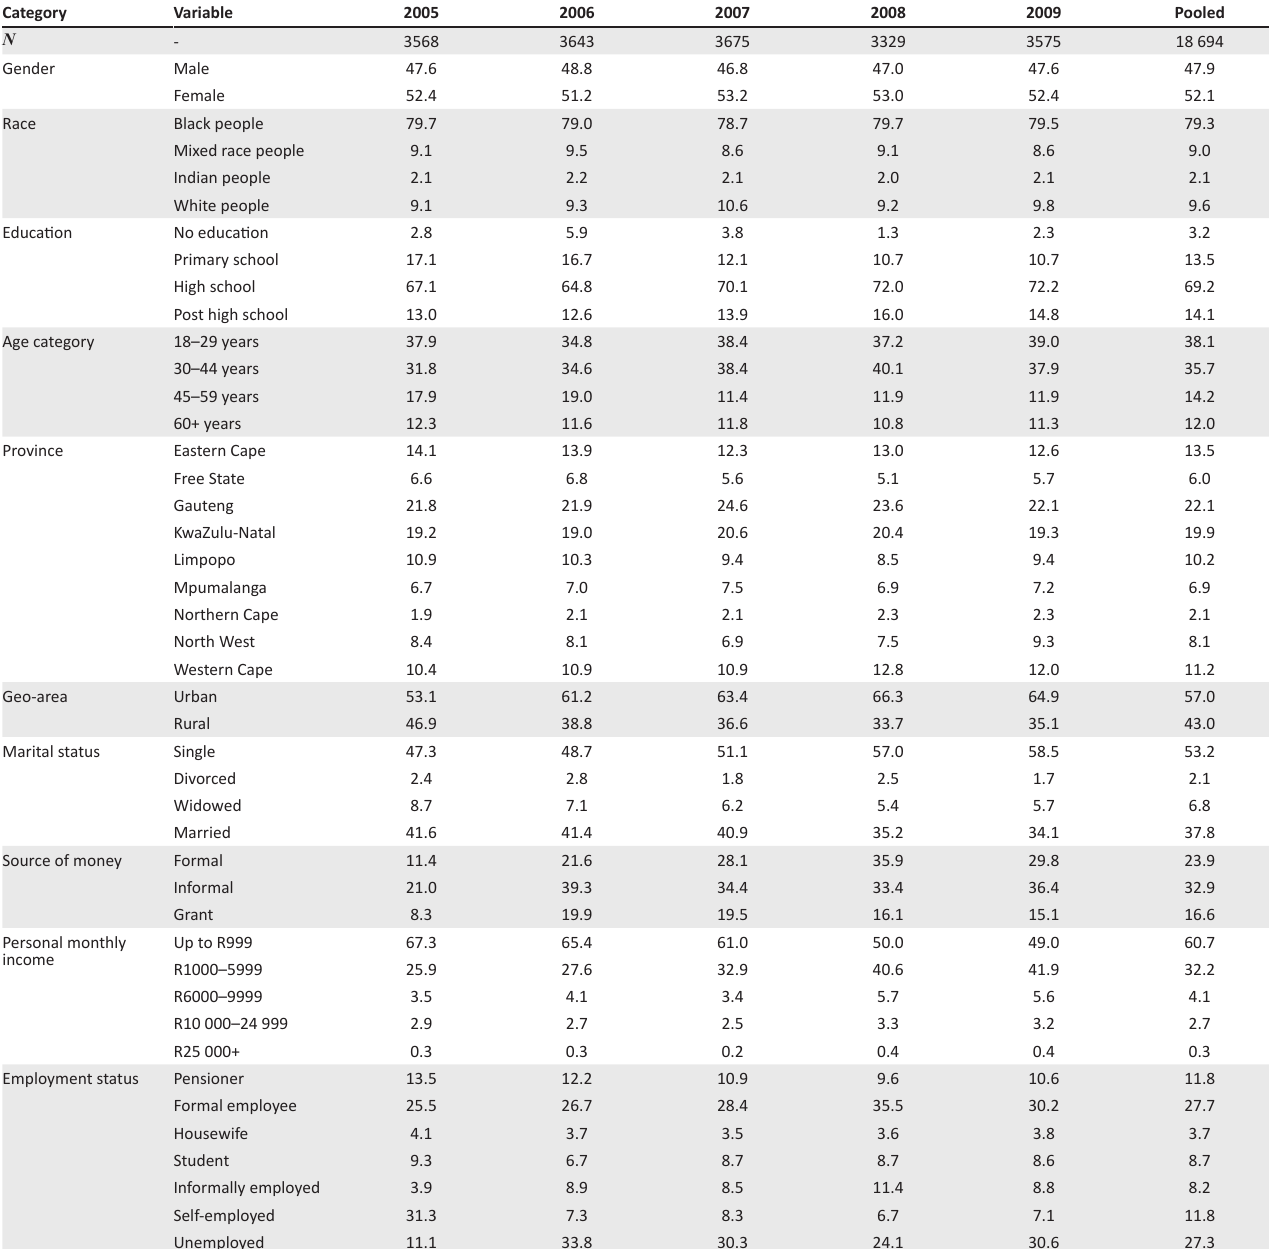
TABLE 1: Summary statistics for the data (2005–2009).